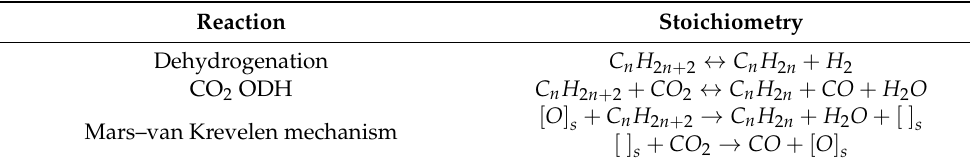
Table 26. Main reactions involved in dehydrogenation mechanisms for olefin synthesis